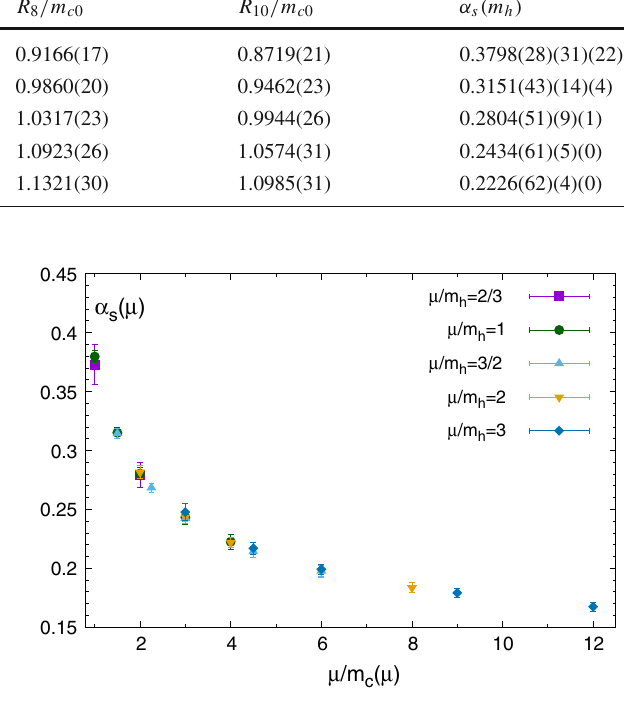
Fig. 2 The strong coupling constant at different scales proportional to m h . The different symbols correspond to the determinations at different values of μ/ m h